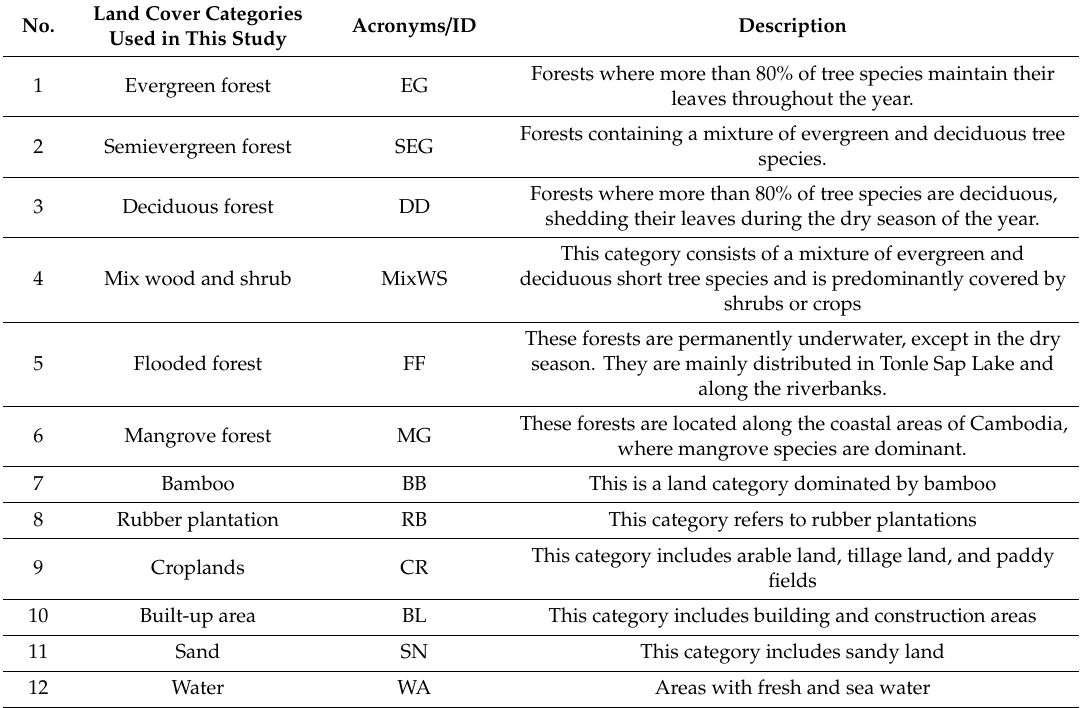
Table 1. The 12 land cover categories those vegetation thresholds are to be determined in this